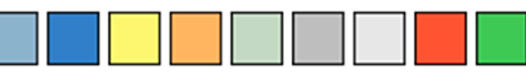
Figure 13. The HERE Maps road network color scheme (top) and replacement suggestions: ( a ) monochromatic color scheme Hue 10, Brightness 100, Saturation from 19 to 75; ( b ) monochromatic color scheme Hue 10, Brightness 100, Saturation from 9 to 39; ( c ) monochromatic color scheme Hue 339, Brightness 86, Saturation from19 to 75; ( d ) monochromatic color scheme Hue 339, Brightness 86, Saturation from 12 to 47.